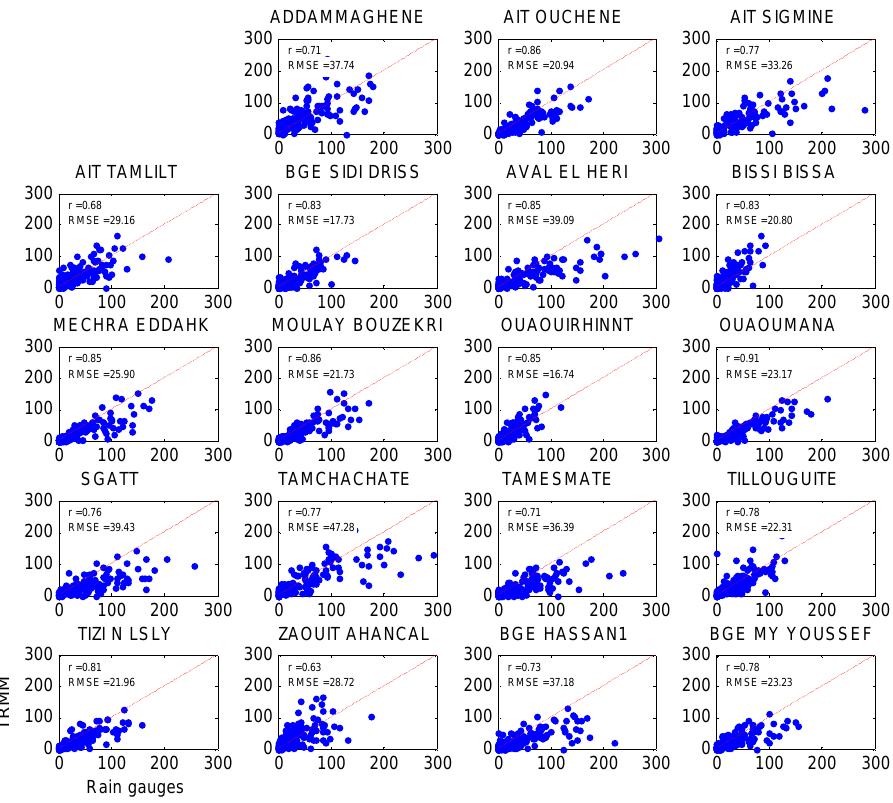
Figure 4. Scatterplot between the 3B42 V7 product and the rain gauges at a monthly time scale over